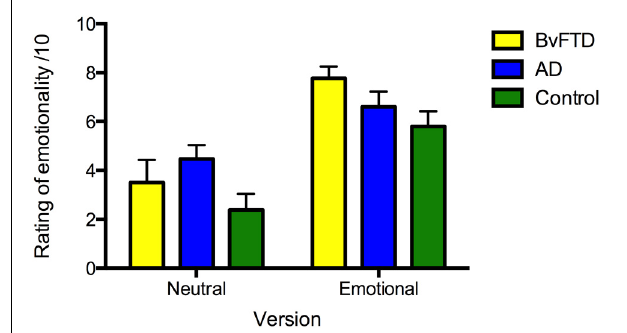
FIGURE 2 | Ratings of perceived emotionality of the neutral and emotional story versions in: behavioral-variant frontotemporal dementia (bvFTD), Alzheimer’s disease (AD), and controls. Maximum rating is 10. Error bars represent standard error of the mean.